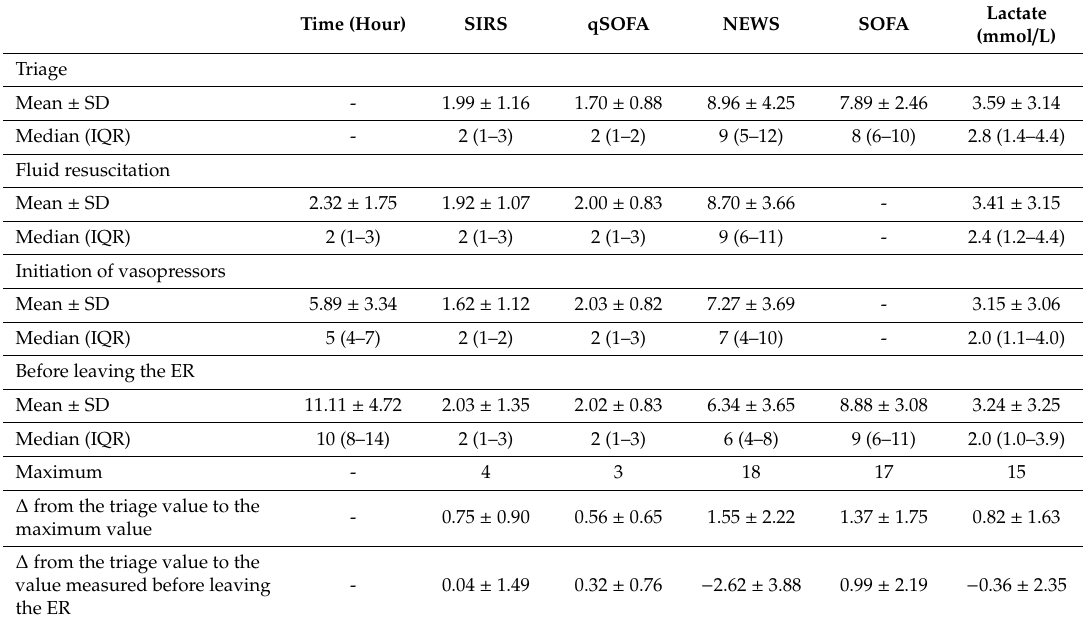
Table 2. Sequential changes in severity